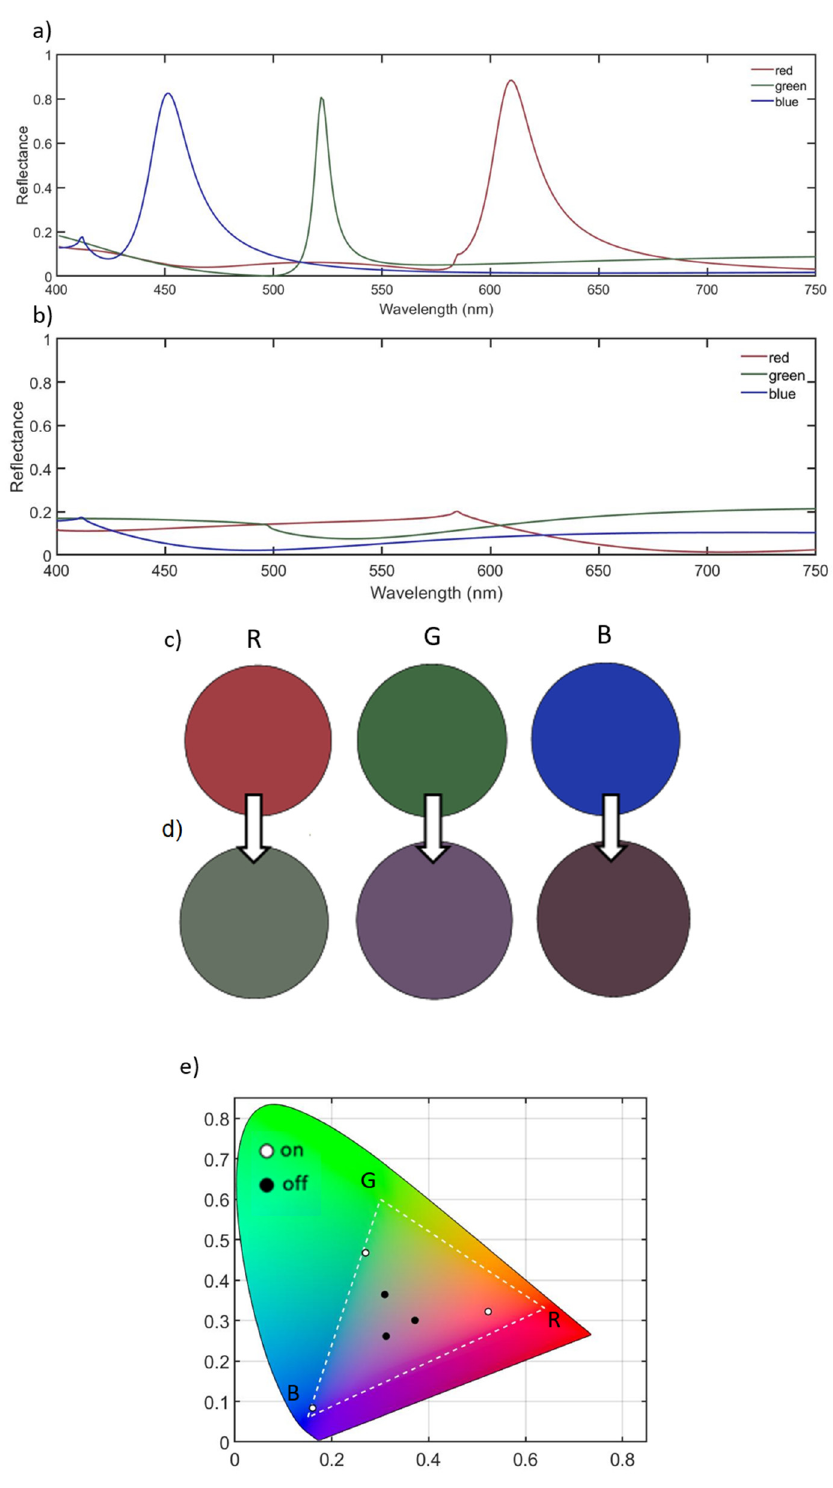
Figure 4. Spectral reflectance of the designed subpixel devices by considering the grating parameters shown in Table 1 for the on ( a ) and off ( b ) states, respectively. On ( c ) and off ( d ) colors generated by the reflective display pixel, respectively. ( e ) Representation of those colors in CIE1931 space. The triangle represents RGB standard coordinates, white points ( on simulated colors), and black points ( off simulated colors).